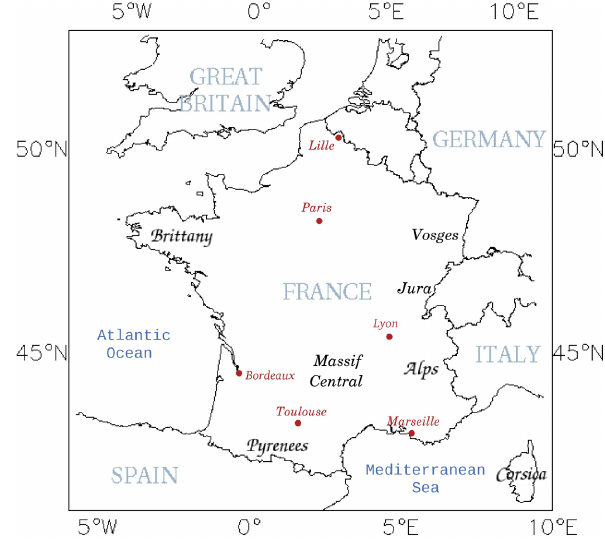
Fig. 1. Map of France, and main areas discussed in this